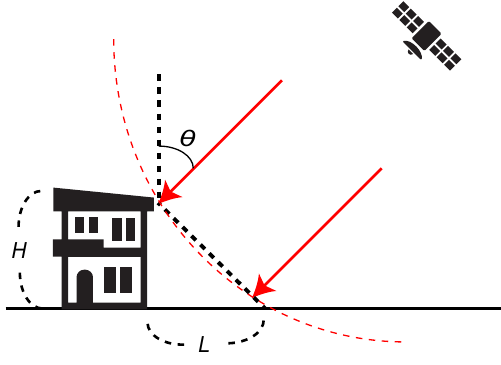
Figure 4. Schematic representation of SAR observations for